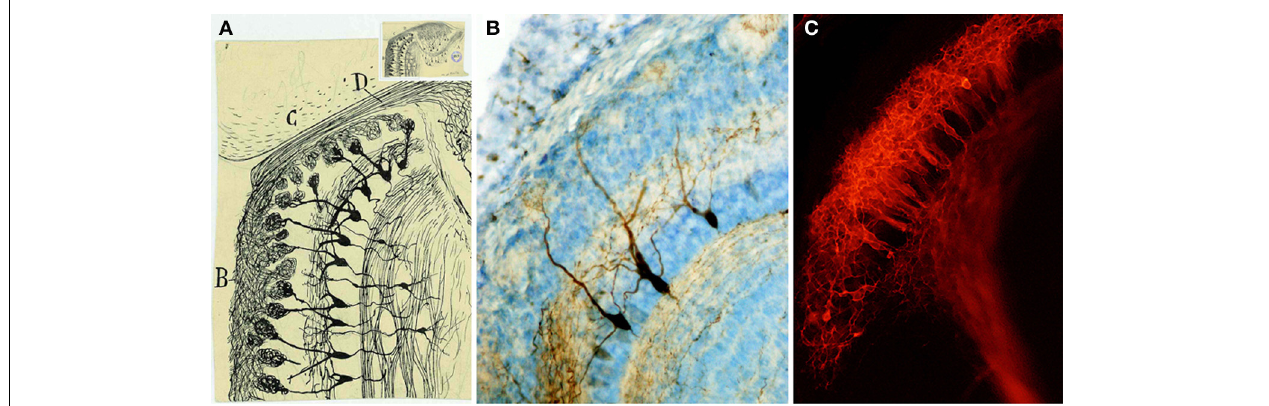
FIGURE 7 | Mitral cells. (A) Magnified detail of the original Cajal figure (upper inset). Horizontal mouse olfactory bulb section at 20-days-old (Ramón y Cajal, 1901). Olfactory bulb (B) , frontal cortex (C) , Olfactory nerve (D) . Cajal Legacy (Instituto Cajal, CSIC, Madrid,